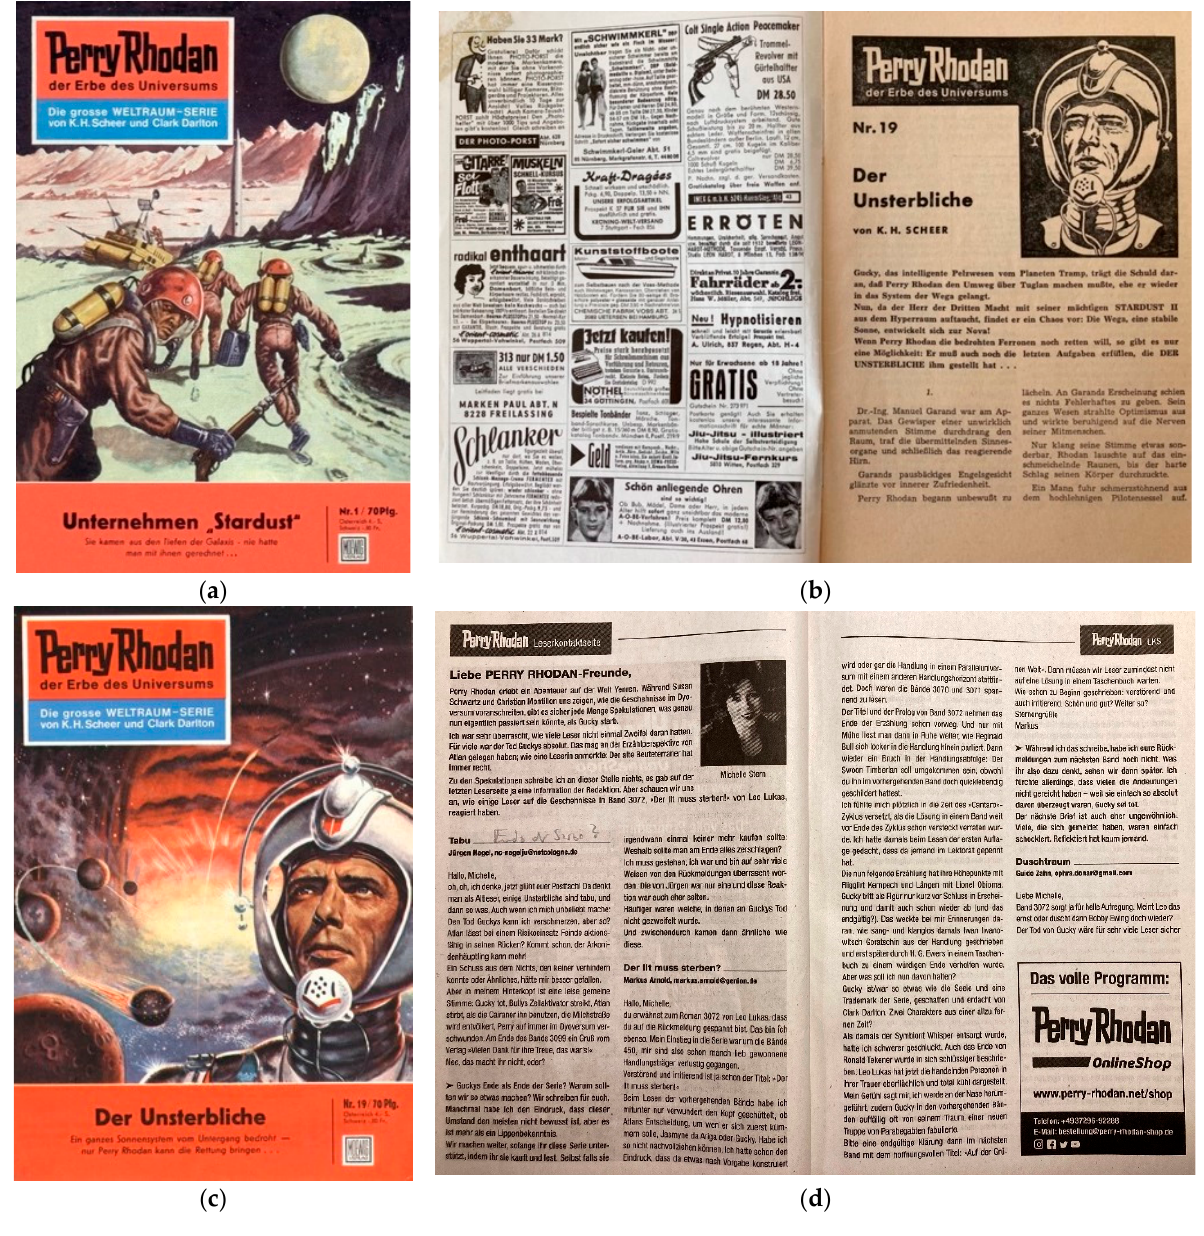
Figure 2. ( a ) Perry Rhodan , cover Issue #1, ( b ) Issue #19 title pages and page 1, ( c ) Cover Issue #19, ( d ) Reader Contact Page: Issue #3079.